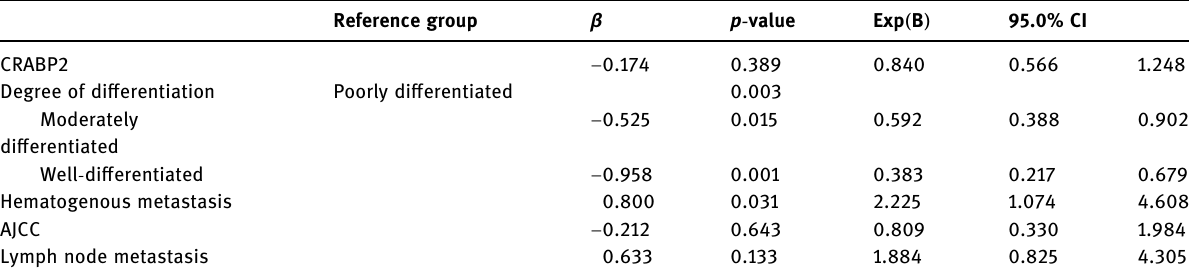
Table 7: Multivariate analysis of factors associated with PFS for ESCC Reference